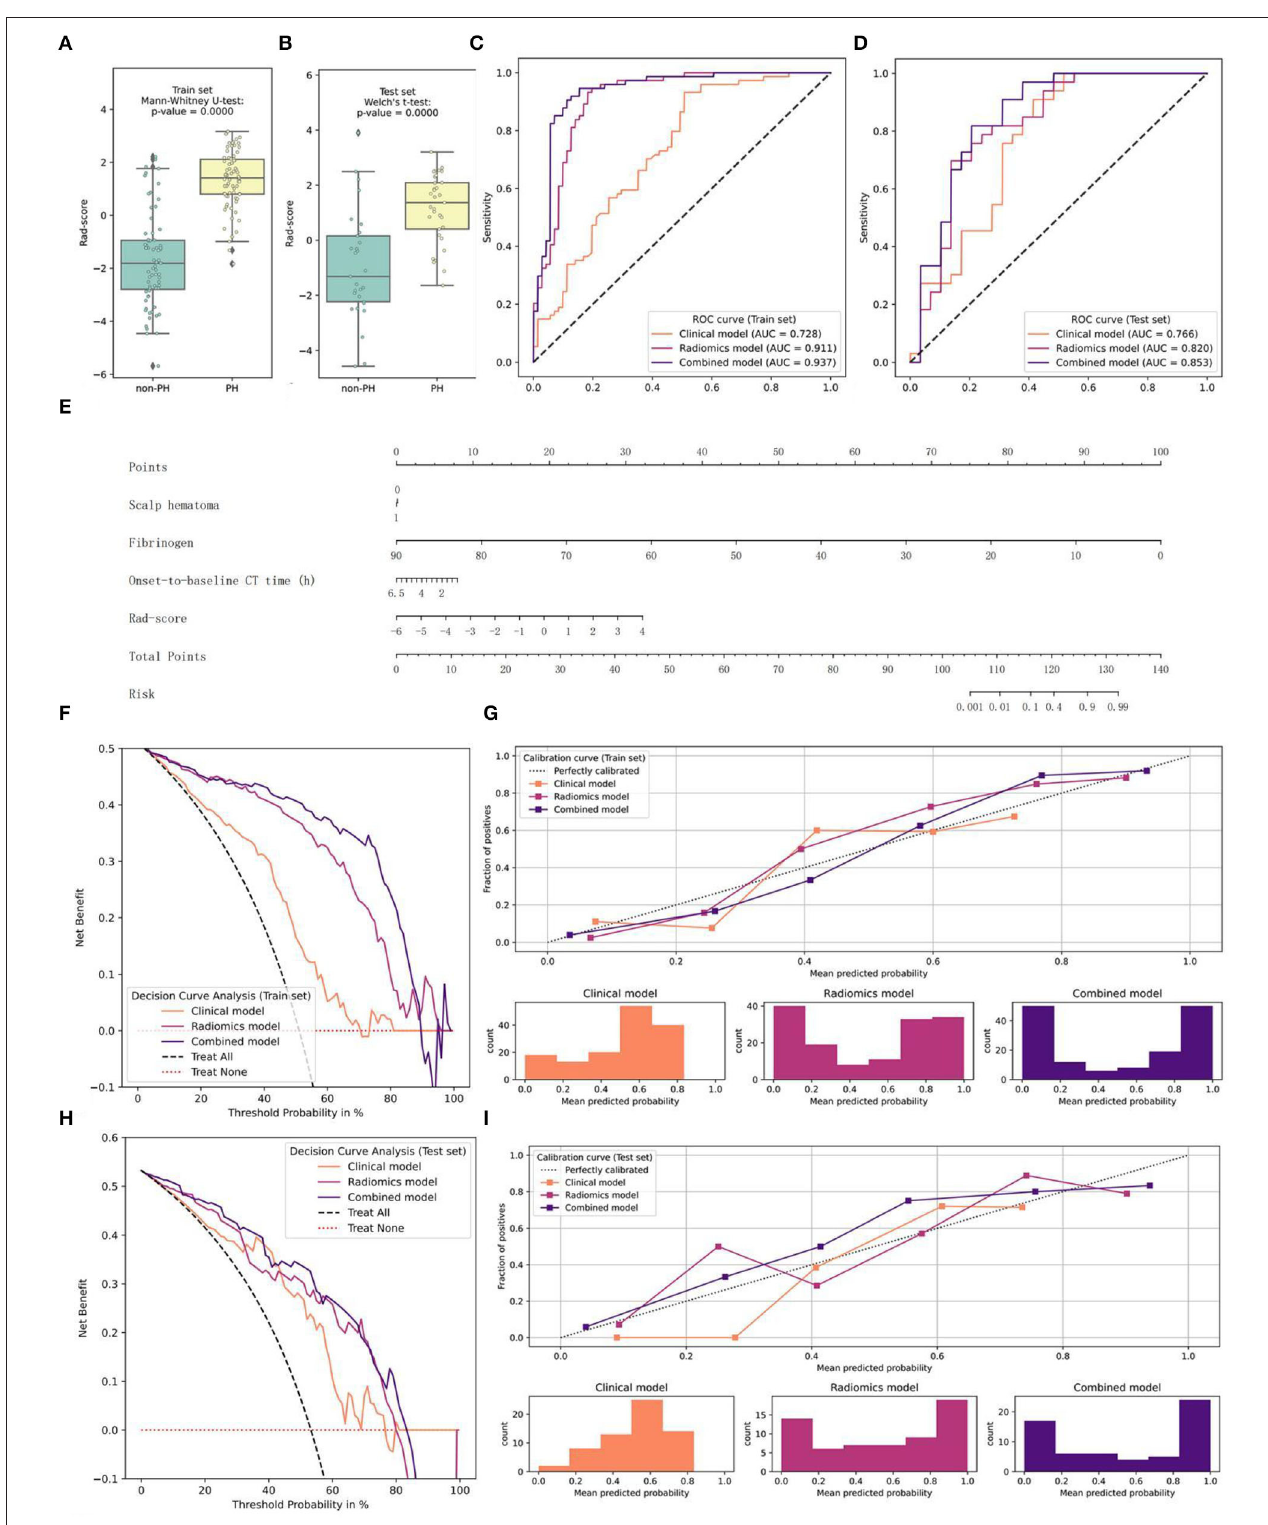
FIGURE 4 | Graphs of the construction of the combined model, the nomogram, and the model comparison. (A,B) The distribution of the Rad-score and the Mann–Whitney U-test results between the two groups on the training and testing sets (E) Nomogram (C–I) Performance of the clinical-radiological, radiomics, and combined models on the training and testing sets (C,D) ROC curves and AUC values (G,I) Calibration curves (F,H) Decision curves.